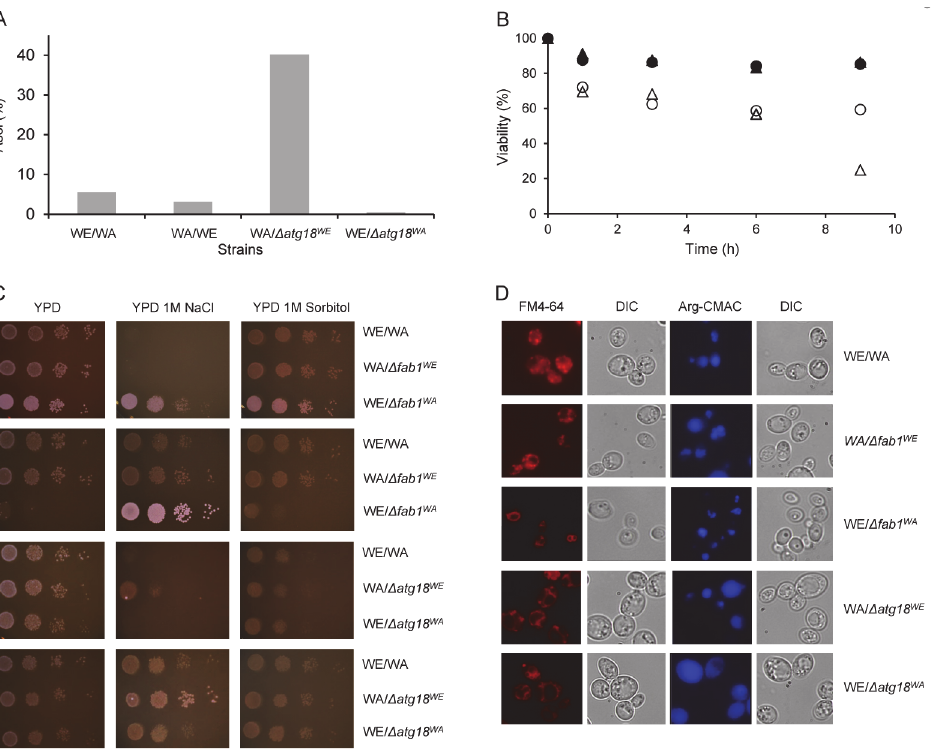
Fig 4. Phenotypic characterization of ATG18 and FAB1 alleles. A) Hemizygous diploid Δ atg18 cells showed different sporulation patterns. After 48 hours on 1% K-acetate, the counted asci were expressed as a percentage of total cells. B) Effect of nitrogen starvation on cell viability of the Δ atg18 strains. The hybrid WE ( Nat R )/WA ( Hyg R ) ( ● ), WA ( Nat R )/WE ( Hyg R ) ( ▲ ), WE/ ATG18 WA ( (cid:4) ), and WA/ ATG18 WE ( Δ ) strains were grown until the mid-log phase in SD and then moved to SD-N. Aliquots were collected and plated on YPD at the indicated times. The scale of viability (%) indicates the percentage of viable cells for the different strains against the time in starvation medium. Values are the mean of triplicate measurements, and the standard deviation was less than 15%. C) FAB1 WA and ATG18 WE rescue cells from ionic-hyperosmotic stress at 37°C. Serial dilutions of heterozygous and hemizygous strain cells were plated on YPD medium, YPD medium containing 1 M NaCl, and 1 M sorbitol and grown at the indicated temperatures. D) Hemizygous cells show vacuole fragmentation and vacuole acidification deficiency. Each pair of image columns show phase microscopy of the same field, which shows cells stained with FM4-64 to visualize vacuole membrane, pH vacuolar dye cell blue Arg-CMAC, and the differential interference contrast (DIC) images.